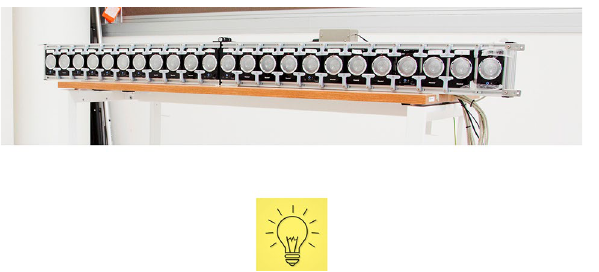
Figure 1. Experimental setup. Participants sat in a silent room, 180 cm away from the center of an array of 23 light-emitting devices spanning ± 25° of visual angle.